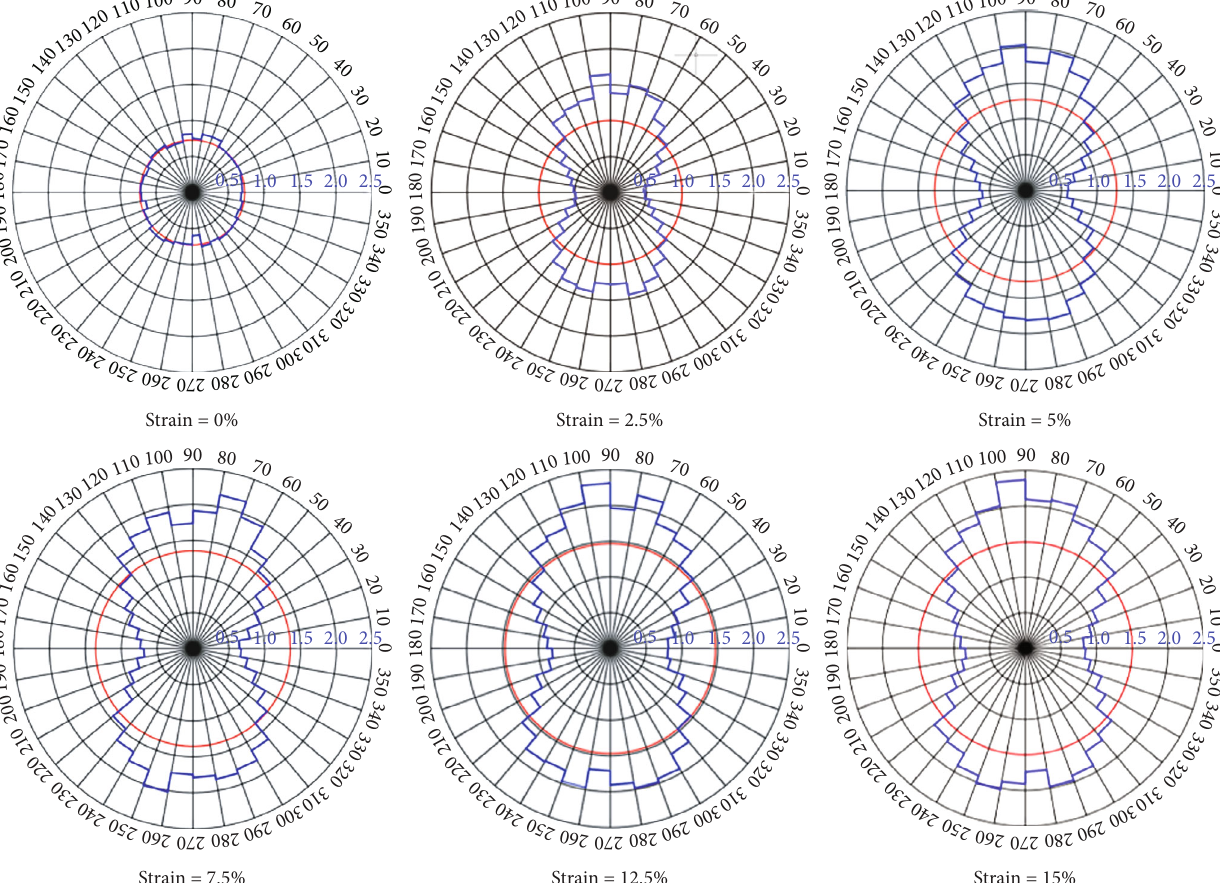
Figure 10: Statistical distribution of normal contact force between particles in gravel soil mixture under di ff erent